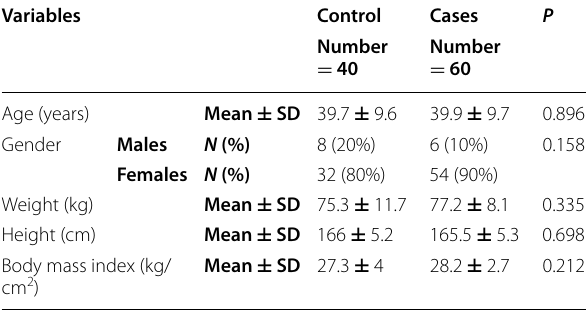
Table 1 Comparisons between group I and group II regarding demographic and anthropometric data